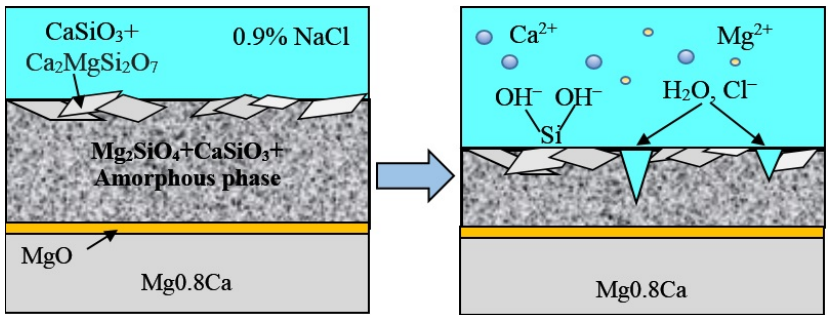
Figure 16. Schematic image of the coating dissolution process in 0.9% NaCl solution. Magnesium silicate, forsterite, and magnesium oxide were mainly formed inside the coating, since Mg, Si, and O prevailed in the elemental composition of the coating’s cross-section. The authors of [69,70] wrote about the formation of forsterite and periclase in the interaction of the electrolyte containing sodium silicate with a magnesium substrate. Furthermore, as was revealed using the SEM EDX method, in addition to the oxide, MgF 2 also formed in the boundary protective layer between the coating and the substrate. Since a halo was observed in the XRD pattern of the coatings, one can conclude that the coatings contained an amorphous phase. Moreover, with an increase in the voltage up to 500 V, the amount of the amorphous phase in the coatings’ phase composition increased dramatically. The dissolution of the coating in the solution of 0.9% NaCl occurred most intensively in the regions between the crystals, where the amorphous phase was predominant (Figure 16). On the other hand, with an increase in the process voltage, the amount of calcium in the coatings rises, which indicates an increase in the involvement of wollastonite in the MAO process. The corrosion resistance of the coatings increased in this case, because it was found that coatings applied at a process voltage of 500 V had the highest corrosion resistance. Sainz et al. [34] described the dissolution process of wollastonite in SBF. The reaction (6) took place in this case: